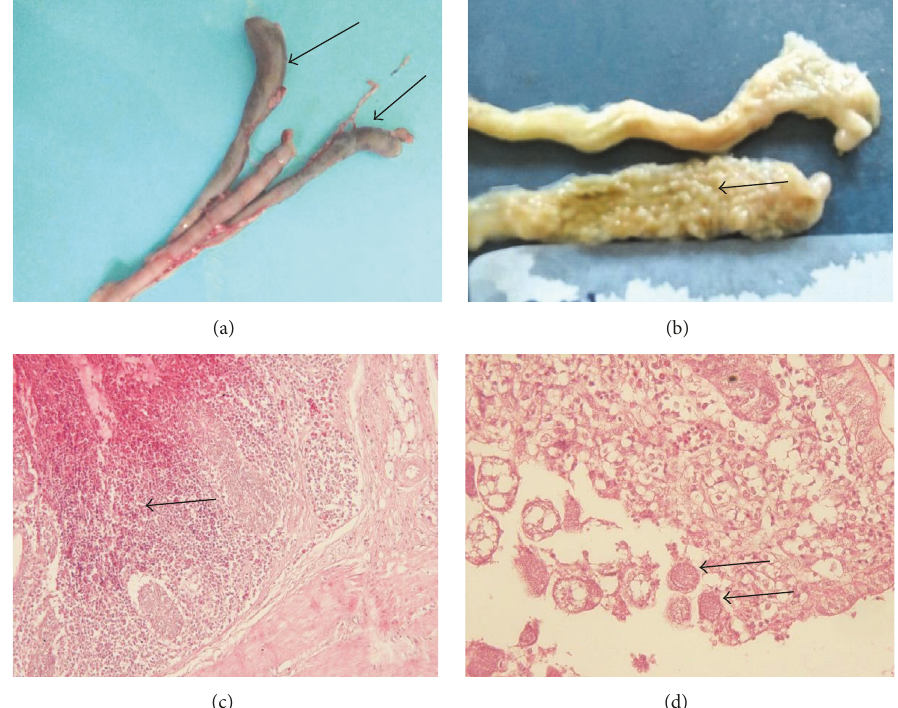
Figure 3: Macroscopic lesions and histopathologic sections of chicken intestine with coccidiosis in Central Java. (a) Macroscopic lesion of the caecum showing ballooning condition (arrows) with bloody lumen. (b) Different pinhead size structures were massively formed in lumen of caecum (arrow). (c) Haemorrhagic and inflammatory cells infiltration (arrow) in the infected caecum. (d) Macrogamonts of Eimeria spp. in the caecum (arrows). The species is identified as E. tenella based on the predilection site (caecum), morphology of oocyst, and sporulation time of collected oocysts from